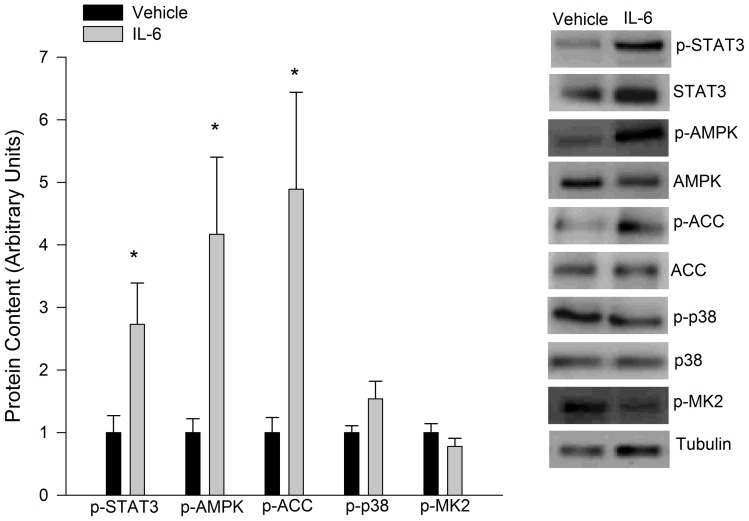
IL-6 signalling in cultured adipose tissue.
Ex vivo IL-6 treatment (150 ng/ml, 30mins) increases the phosphorylation of STAT3, AMPK and ACC but not the p38MAPK signalling pathways in cultured eWAT. Data are presented as means + SE for 7 cultures per group. Representative Western blot images are given to the right of the quantified data. * P<0.05 versus vehicle control.